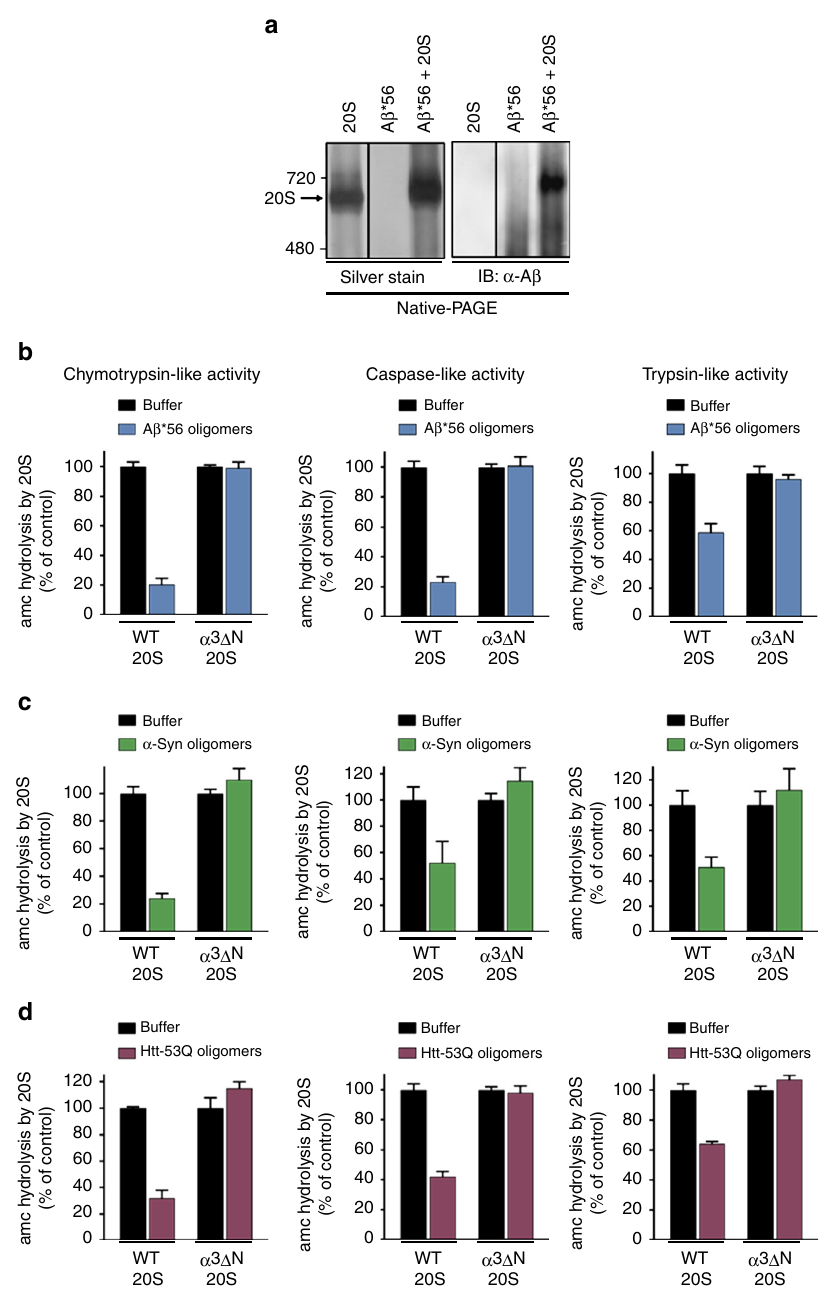
Fig. 3 The A11( + ) oligomers bind to the 20S proteasome and impair opening of the substrate gate. a 20S proteasomes (0.4 μ g) and pure non-crosslinked A β *56 oligomers (1.5 μ g) were incubated separately or together for 30 min (37 °C), crosslinked with 1 mM glutaraldehyde for 5 min, and separated by Native-PAGE (4 – 8% Tris – acetate gel). Total protein was detected by silver stain (left), and total A β was detected by western blot (right). b – d The activity of yeast 20S wild-type (WT) and open-gate ( α 3 Δ N) proteasomes was measured for all three proteolytic sites in the presence of A11( + ) oligomers from A β *56 ( b ; 2.5 μ M), α -Syn ( c ; 100 nM), and Htt-53Q ( d ; 50 nM). Chymotrypsin-like activity was measured by LLVY-amc hydrolysis, trypsin-like activity by RLR-amc, and caspase like by nLPnLD-amc hydrolysis. The concentrations of aggregates are calculated based on the respective monomeric peptide/ protein mass. All controls contained an equal volume of buffer identical to that of the respective aggregates. The data are representative of three or more independent experiments performed in triplicate. Error bars represent ± standard